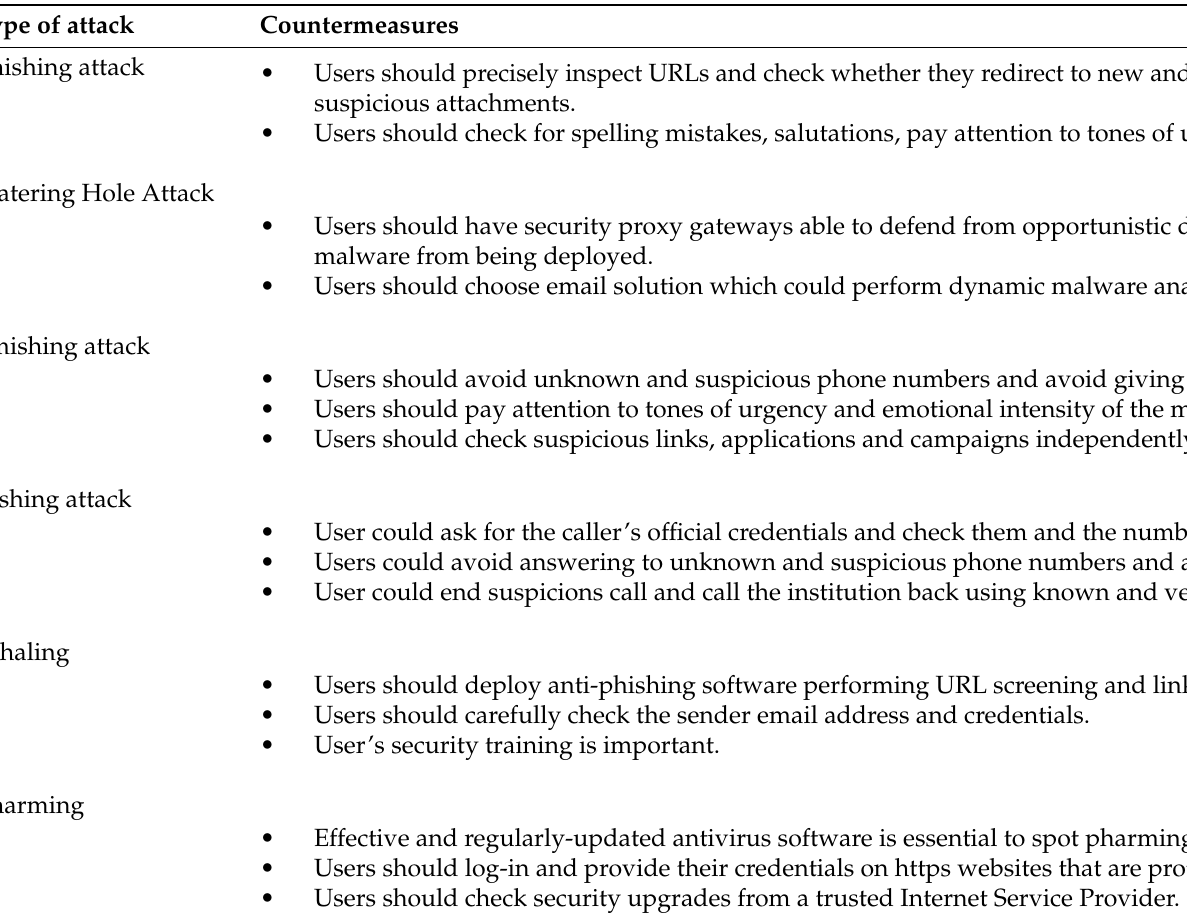
Table 1. Common social engineering attacks and countermeasures. Own elaboration based on